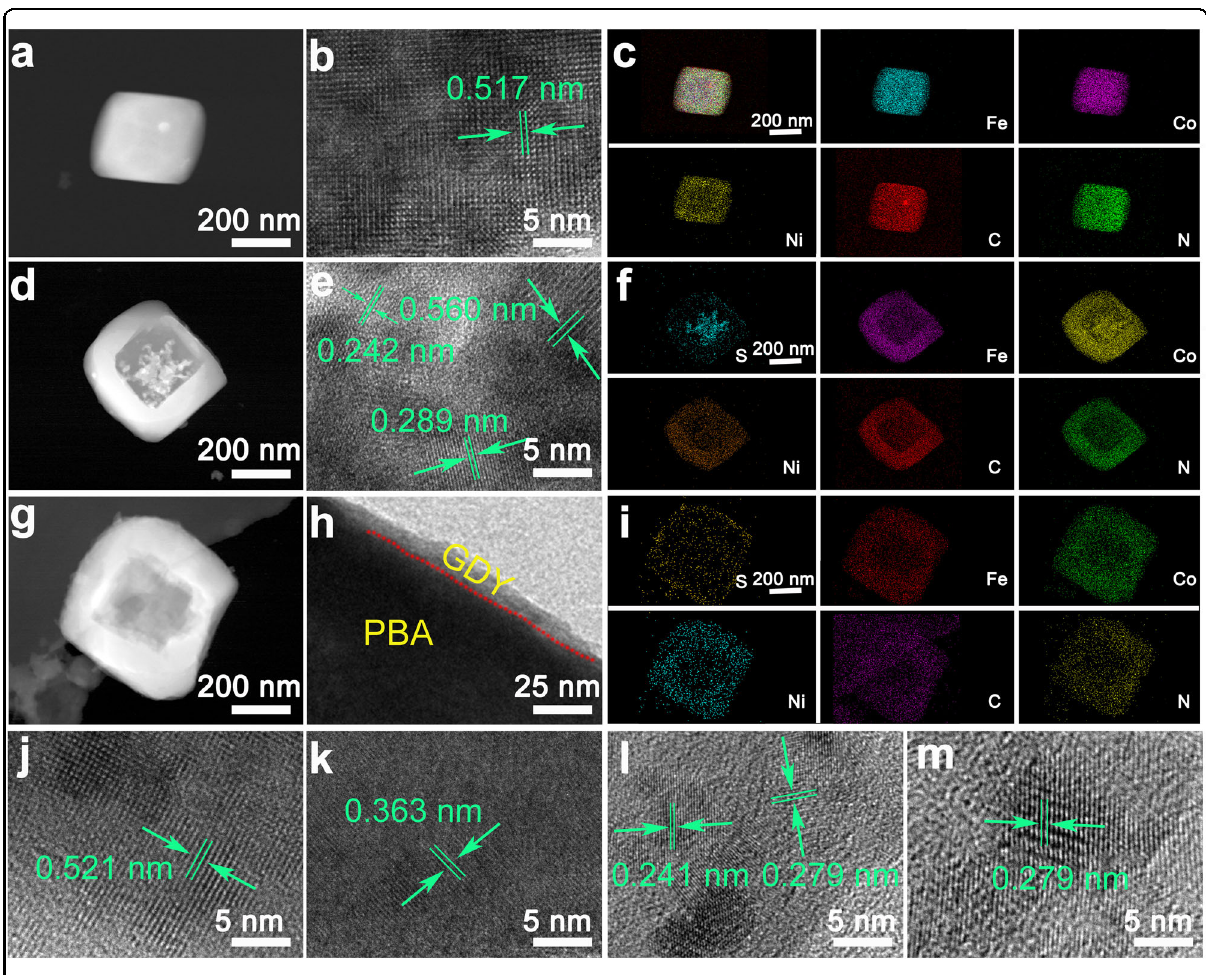
Fig. 3 Transmission electron microscopy analyses. a STEM, b HRTEM and c elemental mapping images for FeCoNi PBA. d STEM, e HRTEM, and f elemental mapping images for h -FeCoNi PBA. g STEM, h , j , k , l , m HRTEM and i elemental mapping images for h -FeCoNi